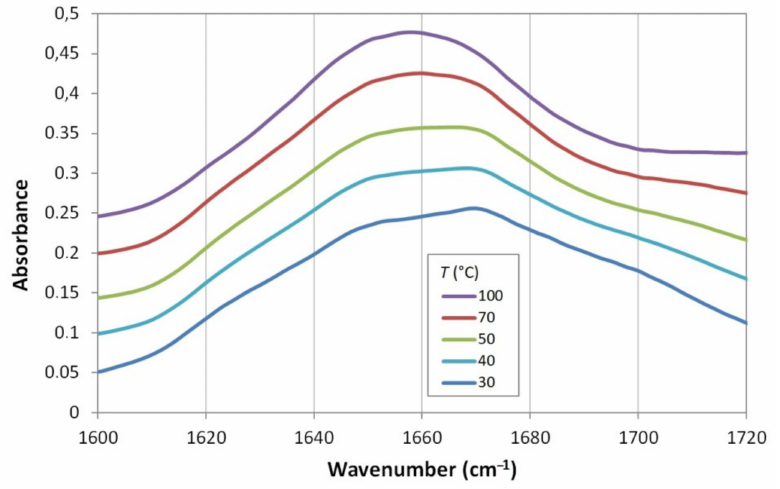
Figure 4. Infrared spectrum of HepB1 in the range of the C=O vibration at selected temperatures.